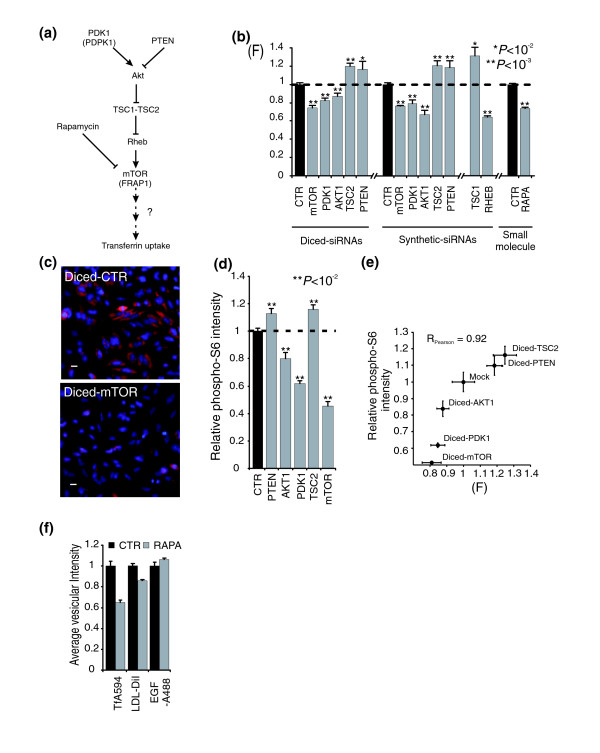
The PtdIns(3,4,5)P3-mTOR signaling pathway controls transferrin uptake. (a) Schematic representation of the PtdIns(3,4,5)P3-mTOR signaling pathway. (b) Quantification of the effects of different siRNAs targeting the PtdIns(3,4,5)P3-mTOR pathway and rapamycin (RAPA) on transferrin uptake. Means ± standard error of the mean (SEM; for d-siRNAs, n = 6; for synthetic siRNAs, n = 4; for rapamycin, n = 17). (c-d) Regulation of S6 protein phosphorylation by the PtdIns(3,4,5)P3-mTOR targeting d-siRNAs. Immunofluorescent images compared the effect of mTOR and GL3 luciferase (CTR) knock-downs on phosphorylated S6 protein staining (red). Nuclei are stained with Hoechst (blue). Scale bars, 10 μm. Quantification of the staining-associated average fluorescence intensity (d). Means ± SEM (n = 6). (e) Correlation between the effect of d-siRNAs on phosphorylation of S6 protein and transferrin uptake. Means ± standard deviation (n = 2 experiments). (f) Inhibition of mTOR signaling by rapamycin (20 nM, 24 h) preferentially affects transferrin uptake when compared to DiI-labeled LDL or Alexa Fluor 488-labeled EGF. Average vesicular fluorescence intensities were measured. Mean ± SEM (n = 6 replicates).